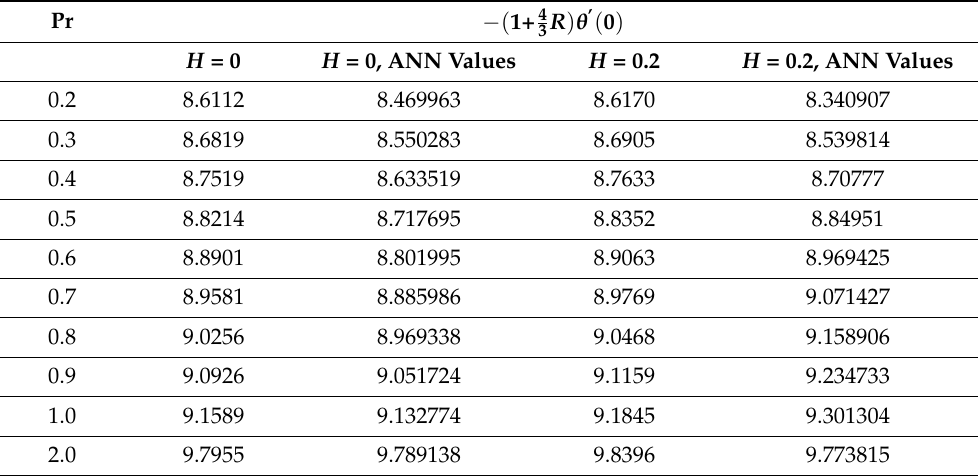
Table 3. Impact of Prandtl number on Nusselt number with and without heat